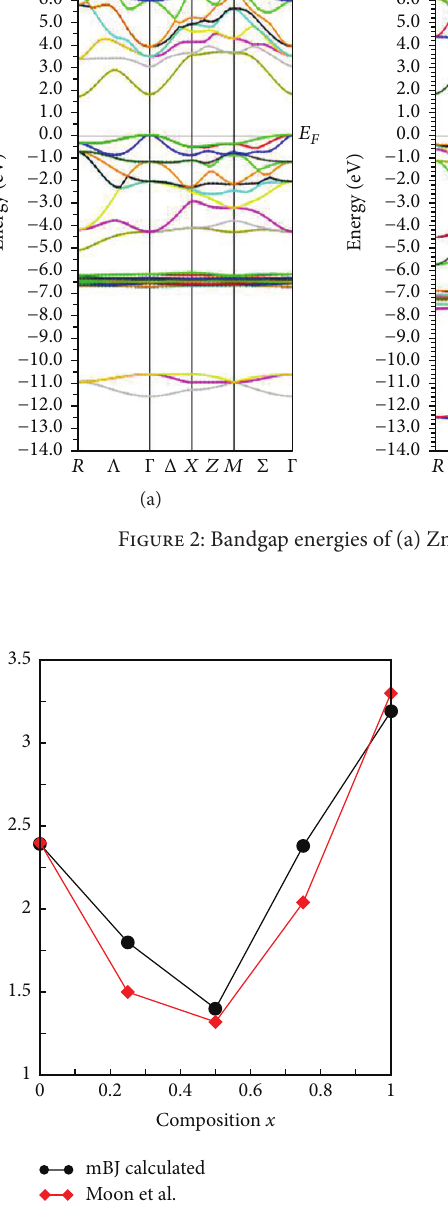
from direct to indirect bandgap are because of the large electronegativity difference between Te and O, variation of bond nature, volume deformation, and charge transfer